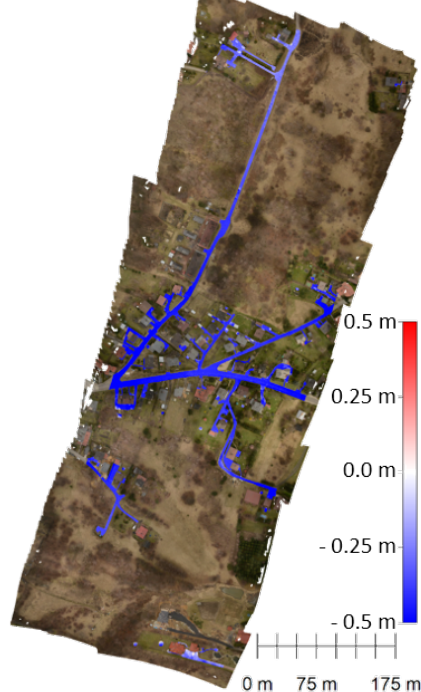
Figure 10 . Example of DoD on hard surfaces created from UAS photogrammetric data collected in March 2018 and ALS data collected in 2011.